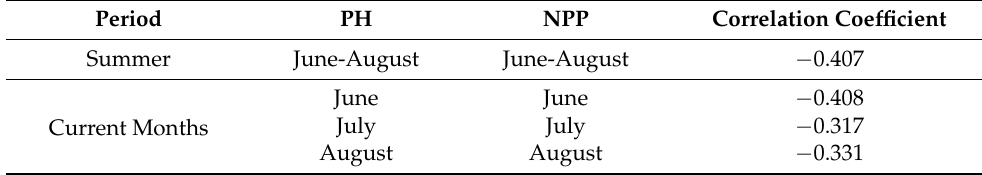
Table 3. Correlation of pH and NPP in summer during